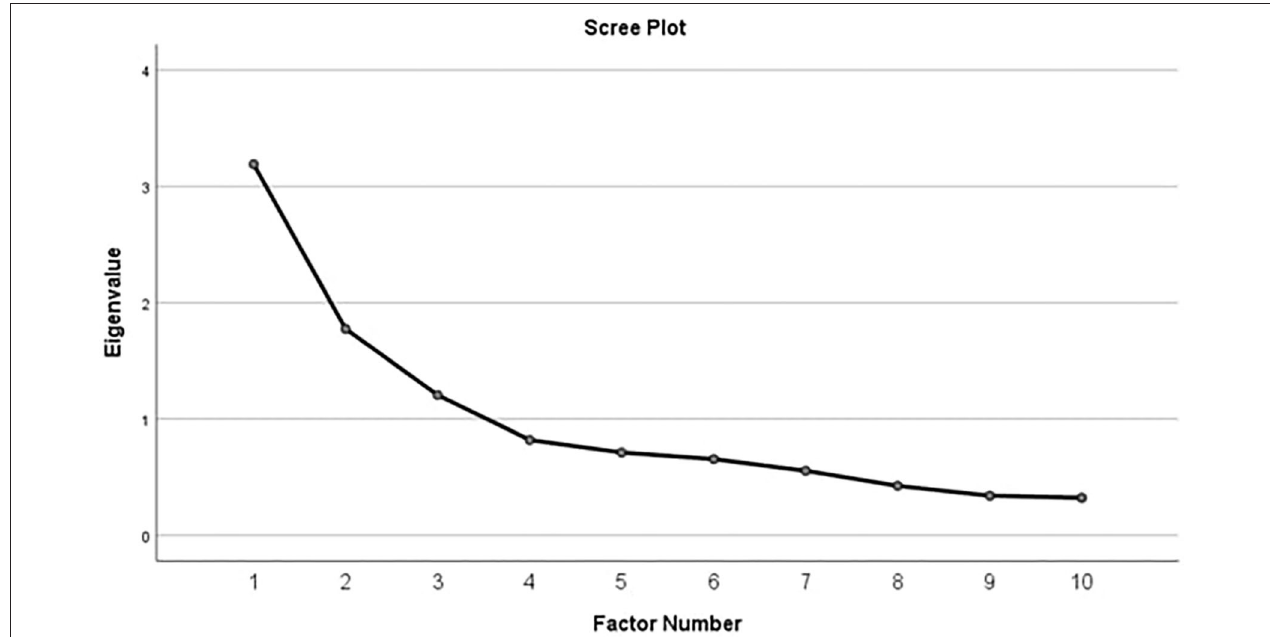
FIGURE 1 | Determining the number of factors based on the scree plot.